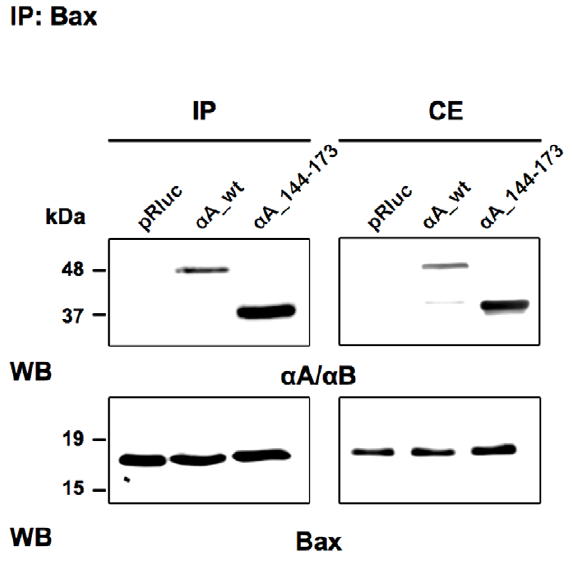
Figure 9. Interaction of the C-terminal extension domain of a A- crystallin with Bax invivo . 293T cells transiently transfected with the empty vector (pRluc), full length a A- ( a A_wt) or mutant a A- ( a A_144- 173) crystallin were further treated with 100 nM STS for 3 h before co- immunoprecipitation with anti-Bax antibody. The precipitated samples were then sequentially probed by western blot using anti- a A/ a B and anti-Bax antibodies. IP: immunoprecipitated samples ( left panels ); CE: 20 m g of total proteins from whole cell extract ( right panels ).